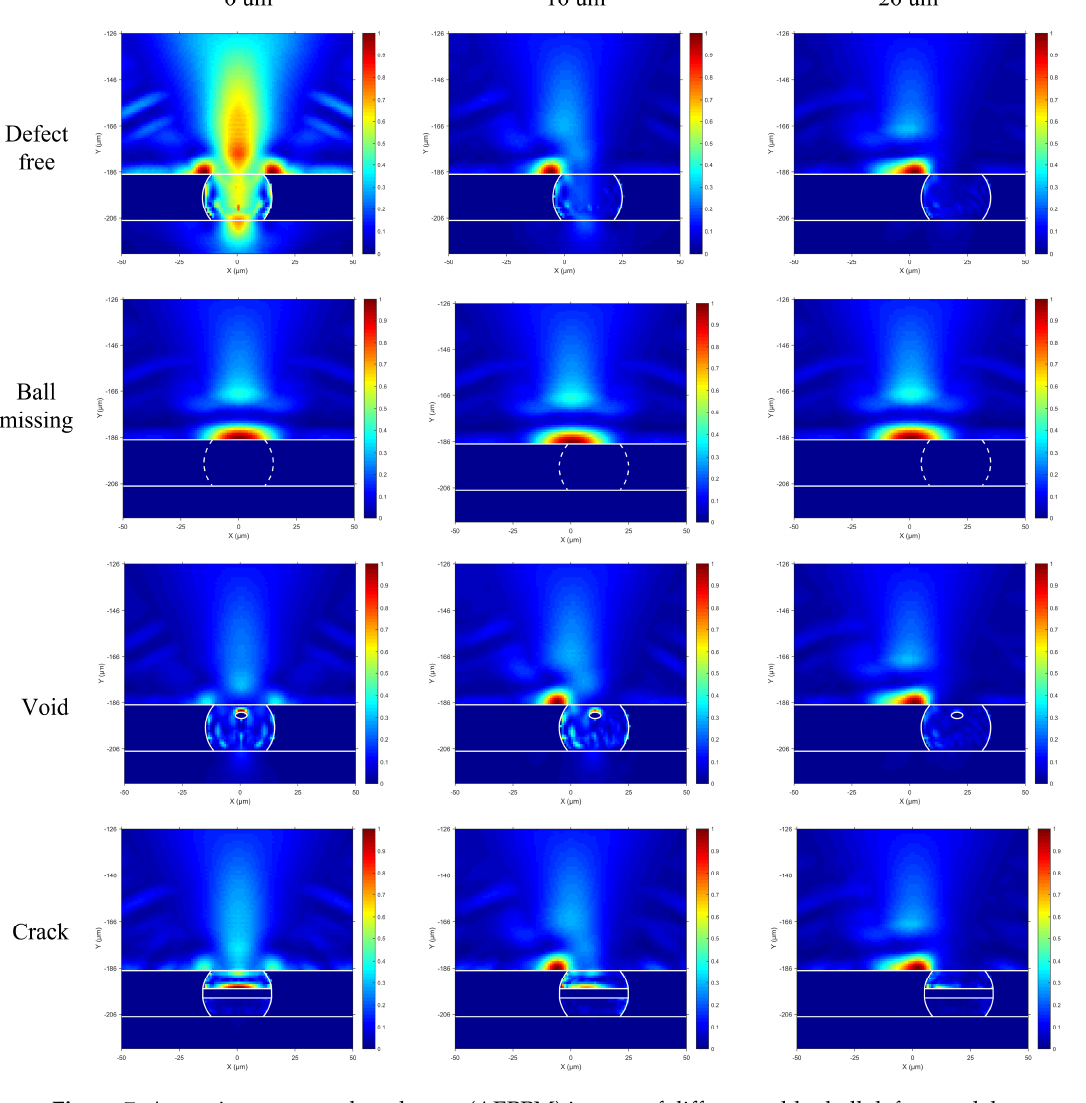
Figure 7. Acoustic energy peak path map (AEPPM) images of different solder ball defect models.